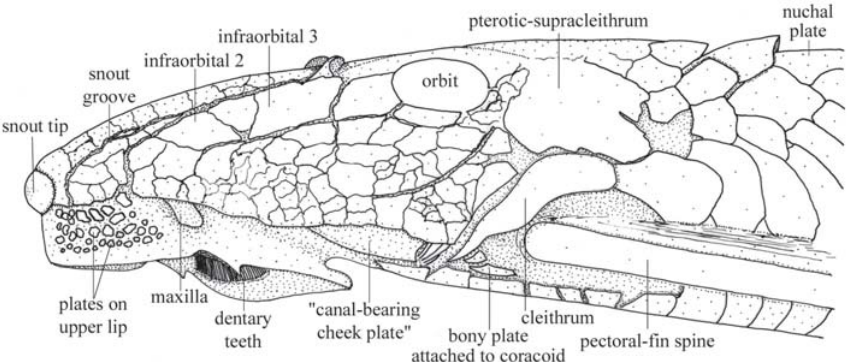
Fig. 51. Lateral view of the head and anterior portion of body of Lamontichthys avacanoeiro (MNRJ 18553, 98.1 mm SL, paratype).